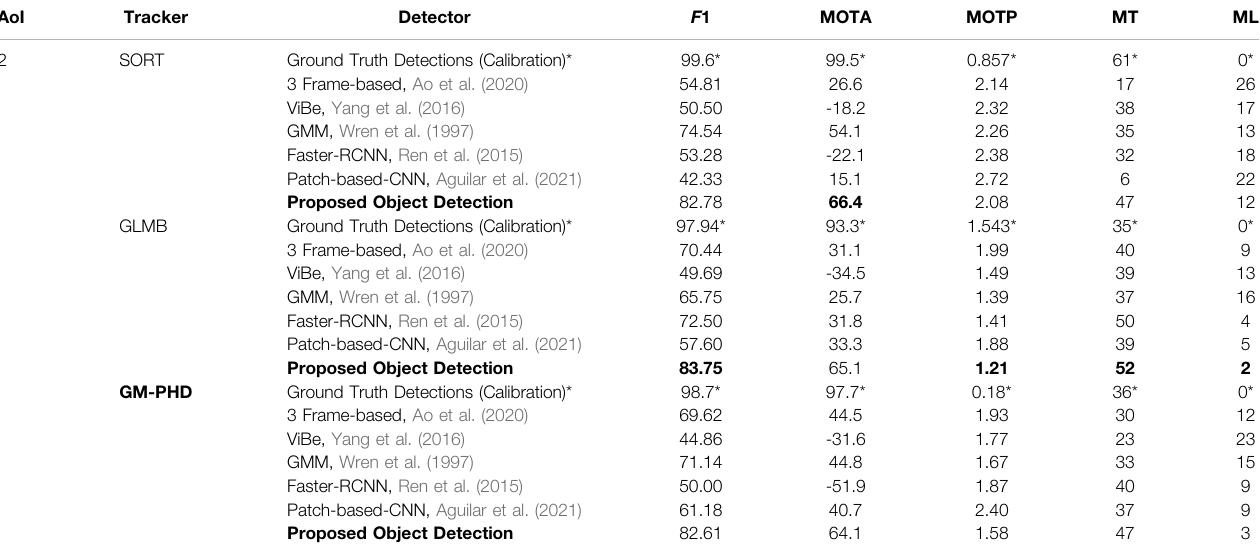
TABLE 5 | Tracking Metrics for AoI 2. *Denotes ground truth measurements used for calibration and fi lter-only testing. AoI Tracker Detector F 1